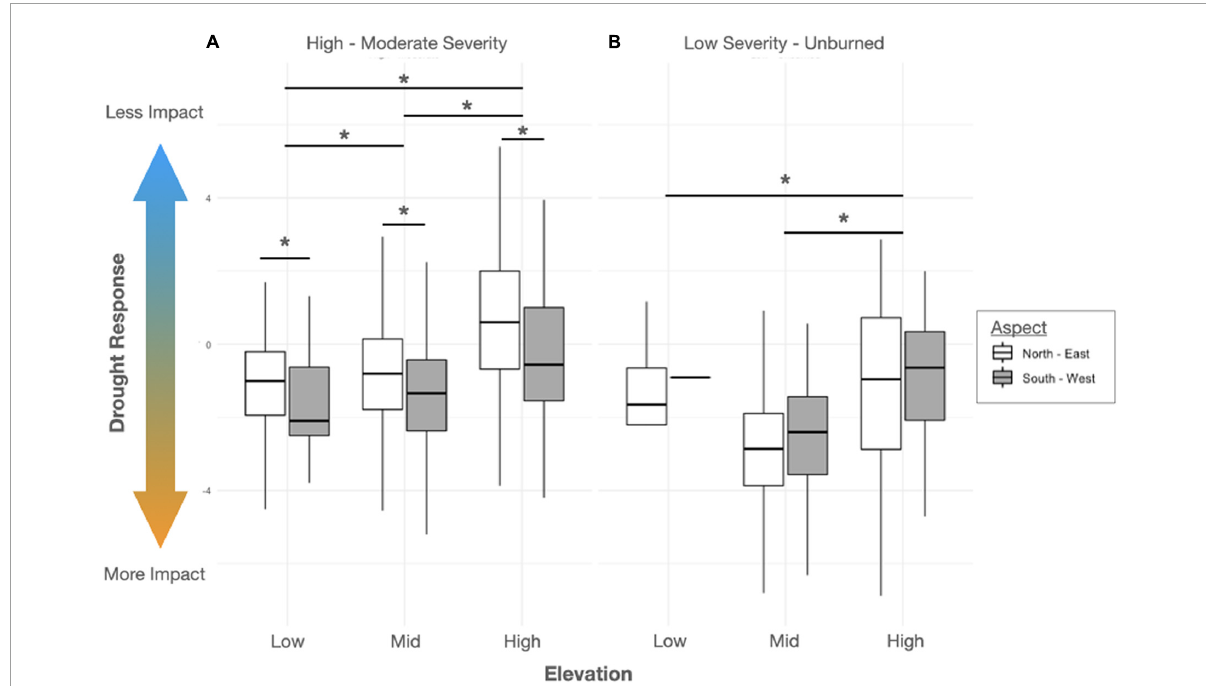
FIGURE6 Boxplots of remotely sensed drought response of bigcone Douglas-fir stands across elevation and aspect groupings for Zaca Fire areas that experienced moderate-high severity (A) or low severity-unburned (B) . Lower values indicate a more negative EVI trend during the multi-year drought period (2012–2016). Bars and asterisks (*) denote significant ( P < 0.05) pairwise differences across groups.